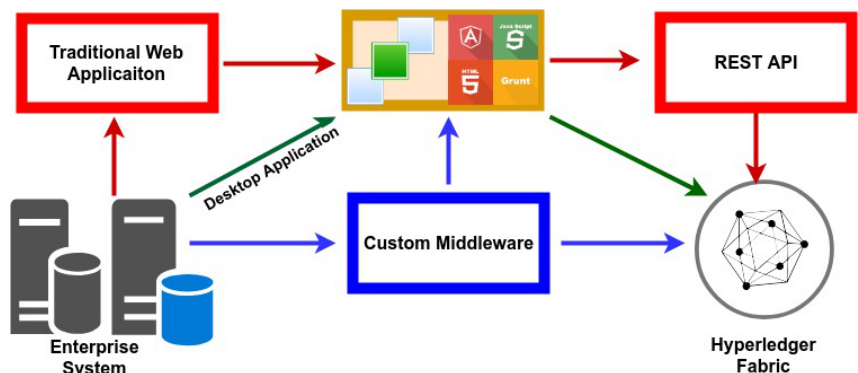
Figure 11. Blockchain Technological Stack to Developed Blockchain